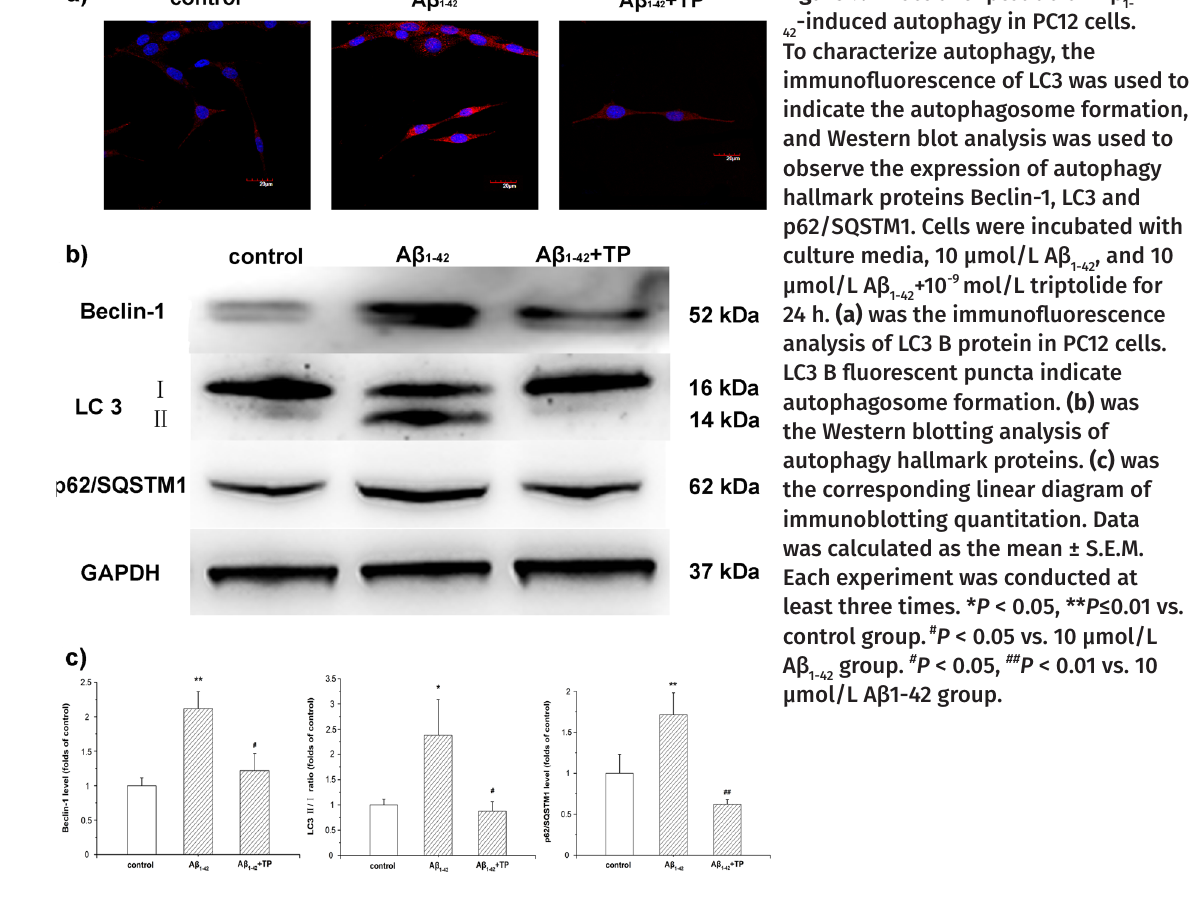
Figure 7. Effect of triptolide on Aβ -induced autophagy in PC12 42